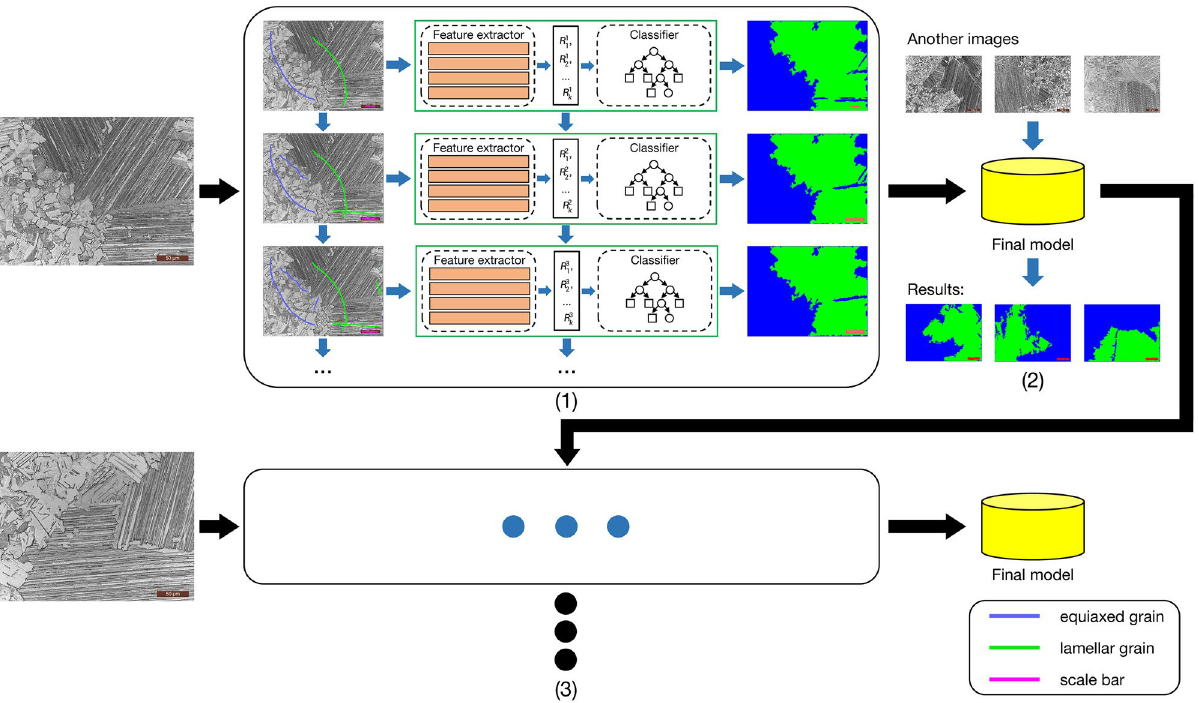
i , R i , ... R i k are the feature 1 2